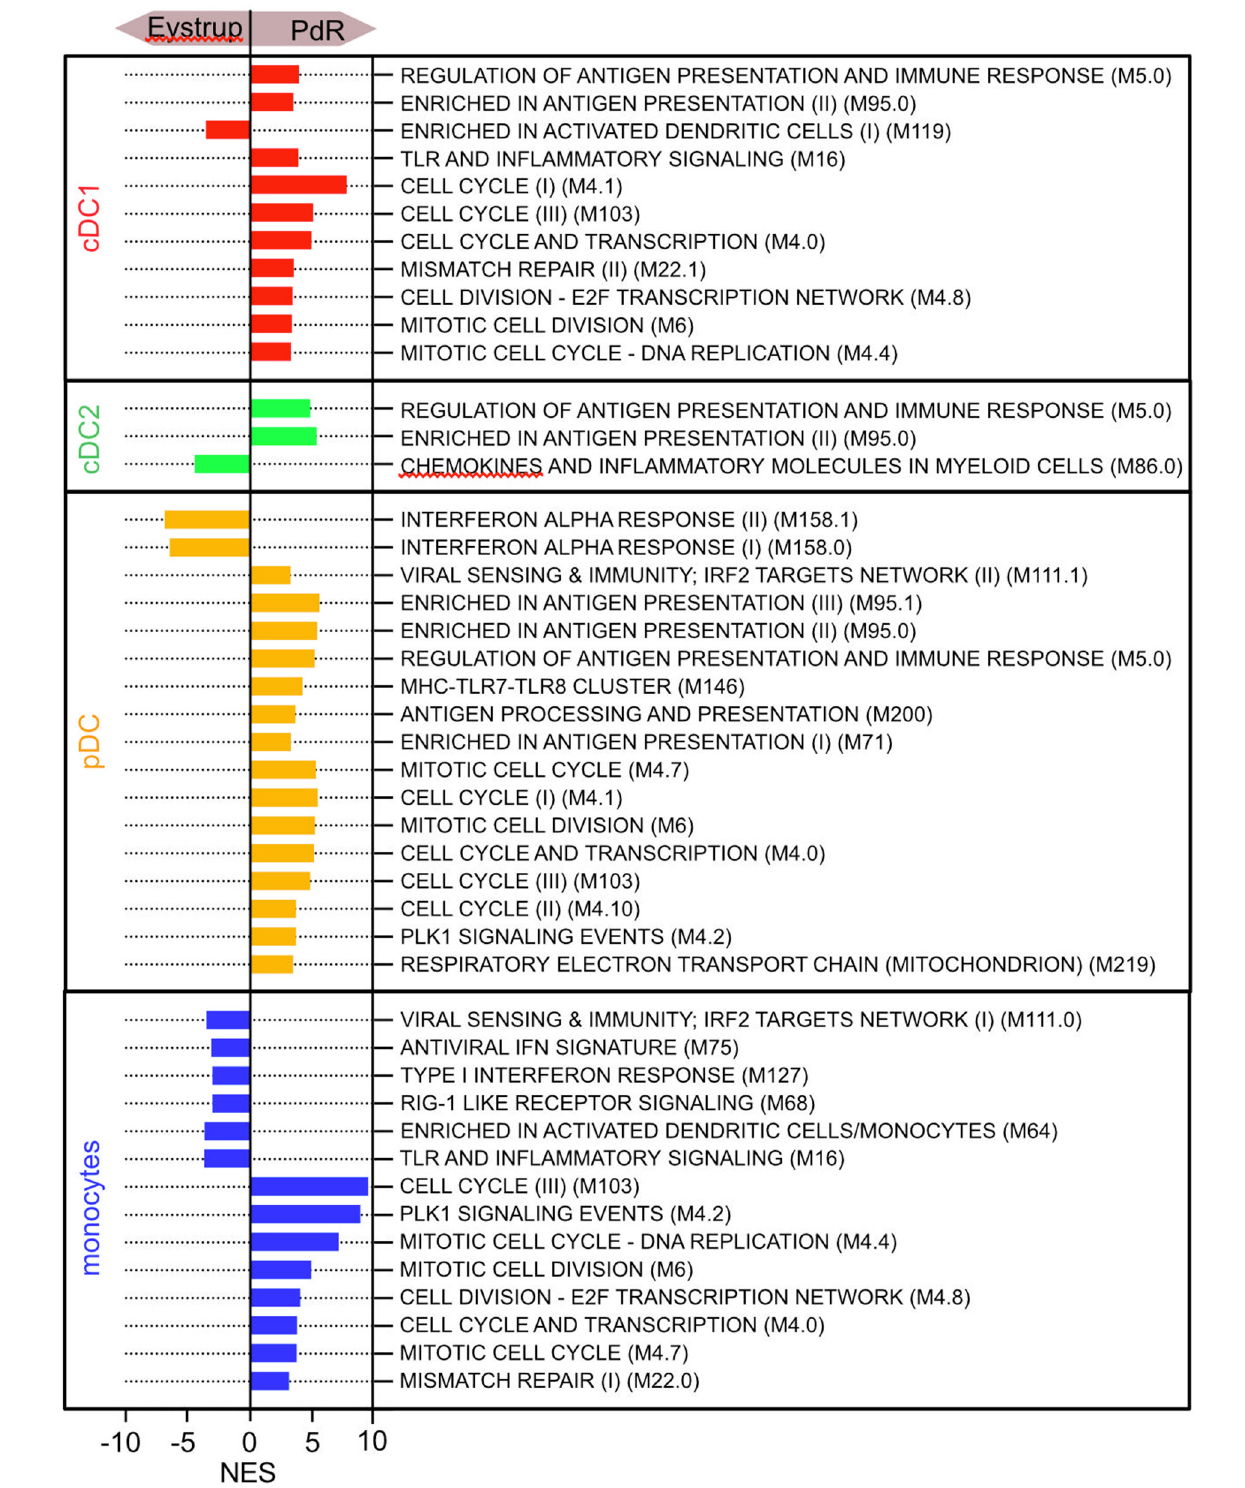
Frontiers in Immunology |